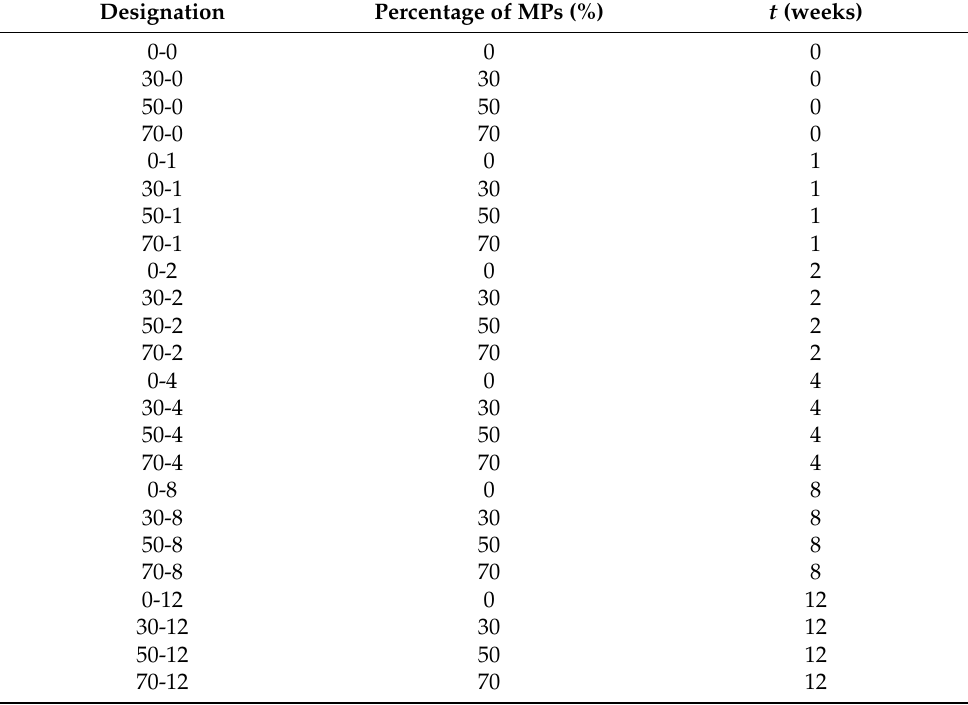
Table 2. Designation of examined samples (left column), where the first number indicates the powder content (middle column), and the second number indicates the duration of incubation (right column).